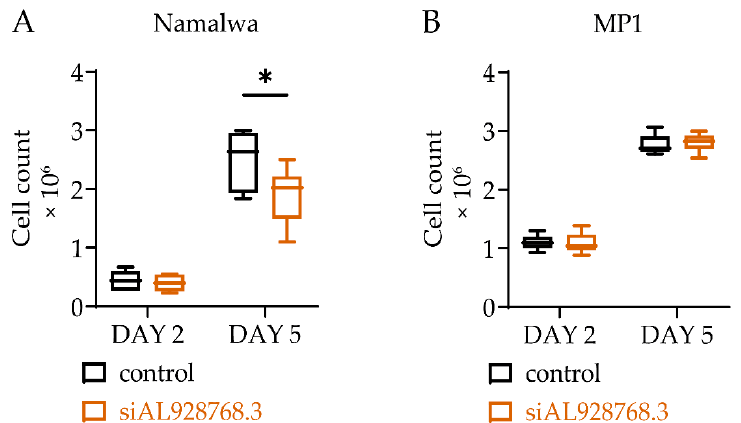
Figure 5. Cell proliferation assay in Namalwa ( A ) and MP1 ( B ) cell lines with the knockdown of AL928768.3. Measurements were taken on the second and fifth days. ScRNA was used as a control. * p -value less than 0.05 (Wilcoxon test). The results of six independent experiments are shown.